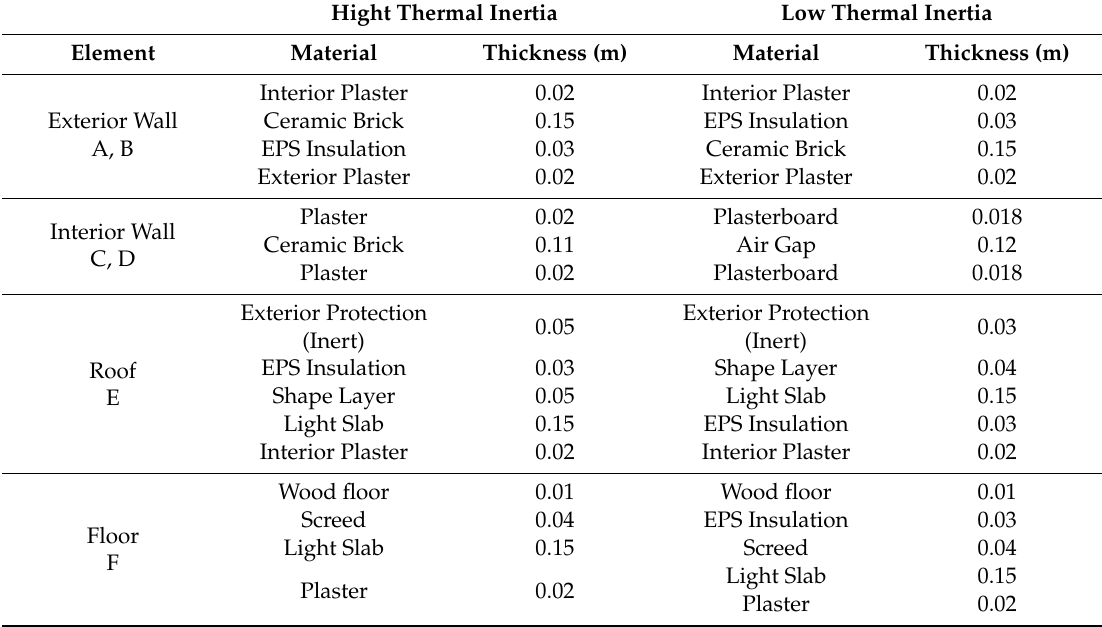
Table 3. Room constructions considered in the High and Low thermal inertia variants.